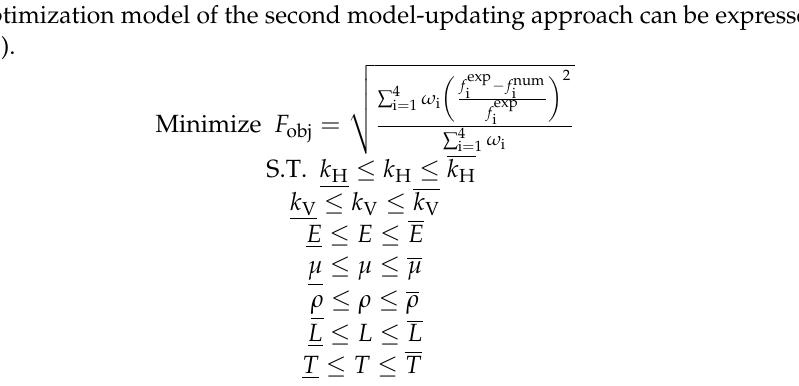
( b ) Figure 12. Switching range of the concerned mode orders. ( a ) First model-updating approach and ( b ) second model-updating approach. Based on the above statistical results, the mode orders to be tracked in the two model- updating approaches were determined, as shown in Table 9.